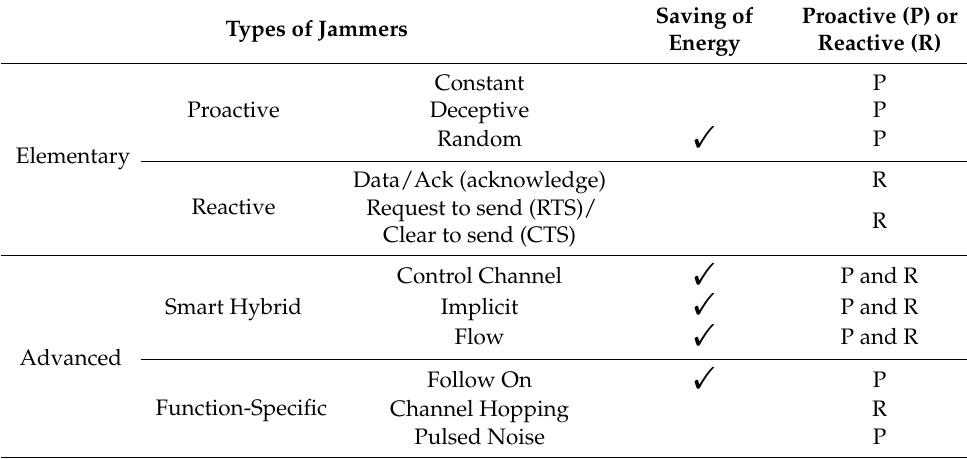
Table 1. Types of jamming